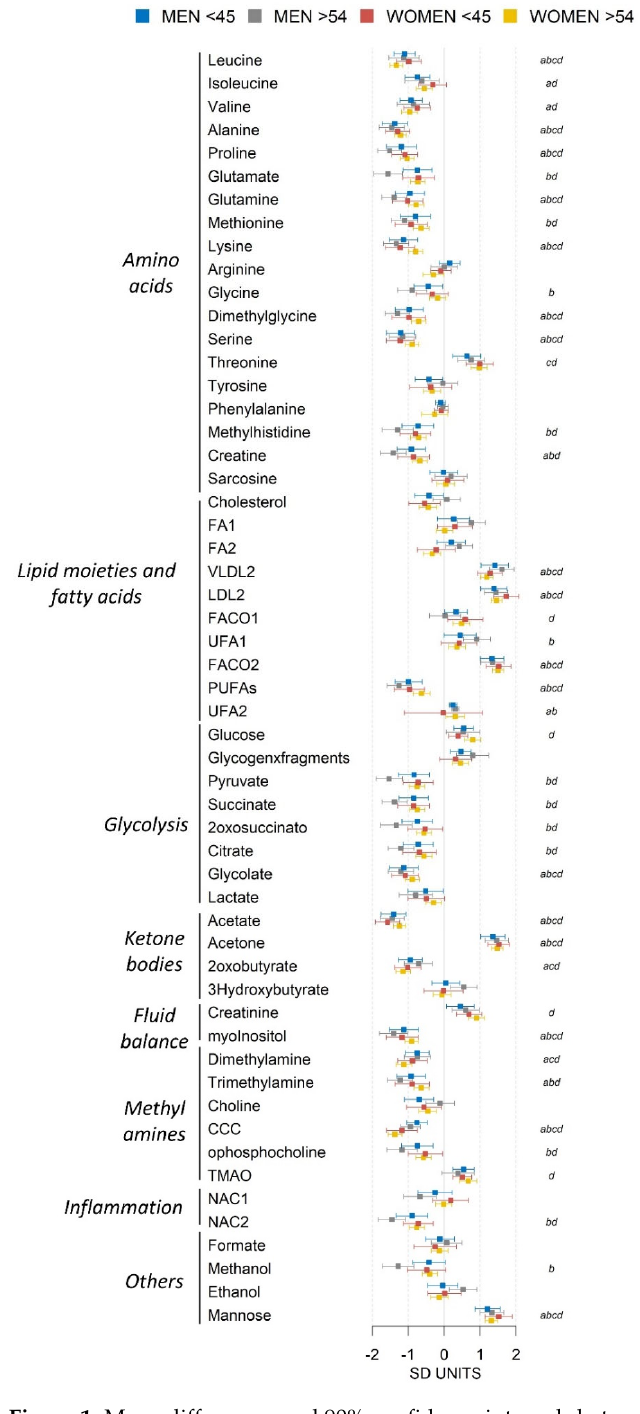
Figure 1. Mean differences and 90% confidence intervals between MetS and MHO expressed in SD units for men (age under 45 in blue, age over 54 in gray) and women (age under 45 in red, age over 54 in yellow) for all the metabolic features measured in the study. Multiple tests corrected statistical significance for the comparison between MHO and MetS ( p -value below 0.00091) is marked with ‘ a ’ (men under 45 years), ‘ b ’ (men over 54 years), ‘ c ’ (women under 45 years) and ‘ d ’ (women over 54 years) in the last column. Key for NMR moieties: FA: fatty acids; FA1: CH3-; FA2: -CH2-; FACO1: -CH2CO; FACO2: -CH2CH2CO; UFA1: =CHCH2CH2-; UFA2 =CHCH2-; PUFAs: =CHCH2CH=; CCC: choline-containing compounds; TMAO: trimethylamine oxide; NAC1/2: acetyls in glycopro- teins; LDL2: low-density lipoprotein 2; VLDL2: very-low-density lipoprotein